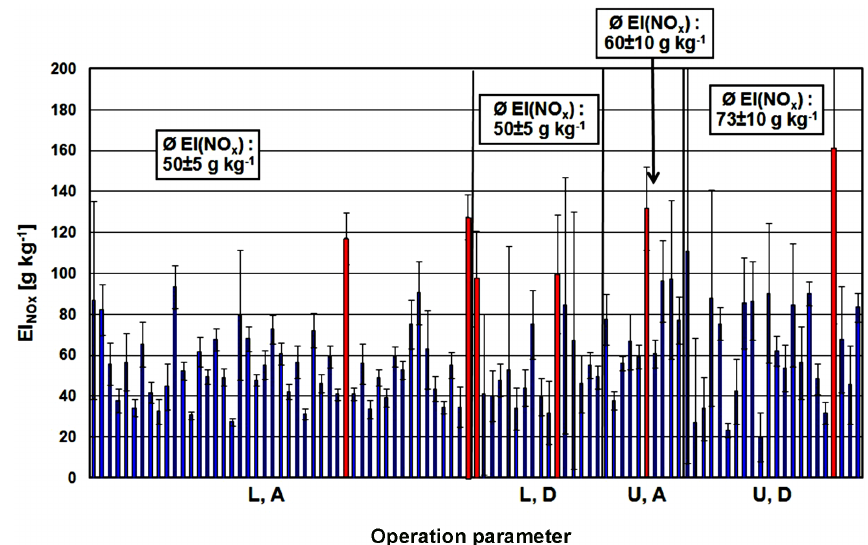
Figure 6. EI NO (as NO 2 ) ingkg − 1 burnt fuel of single-motor ships [goods] and the weighted average value of EI NO x parameters, L = loaded, U = unloaded, A = upstream and D = downstream. Red bars show outliers (4 σ limit) and were not taken into account in the calculation of the weighted average value.